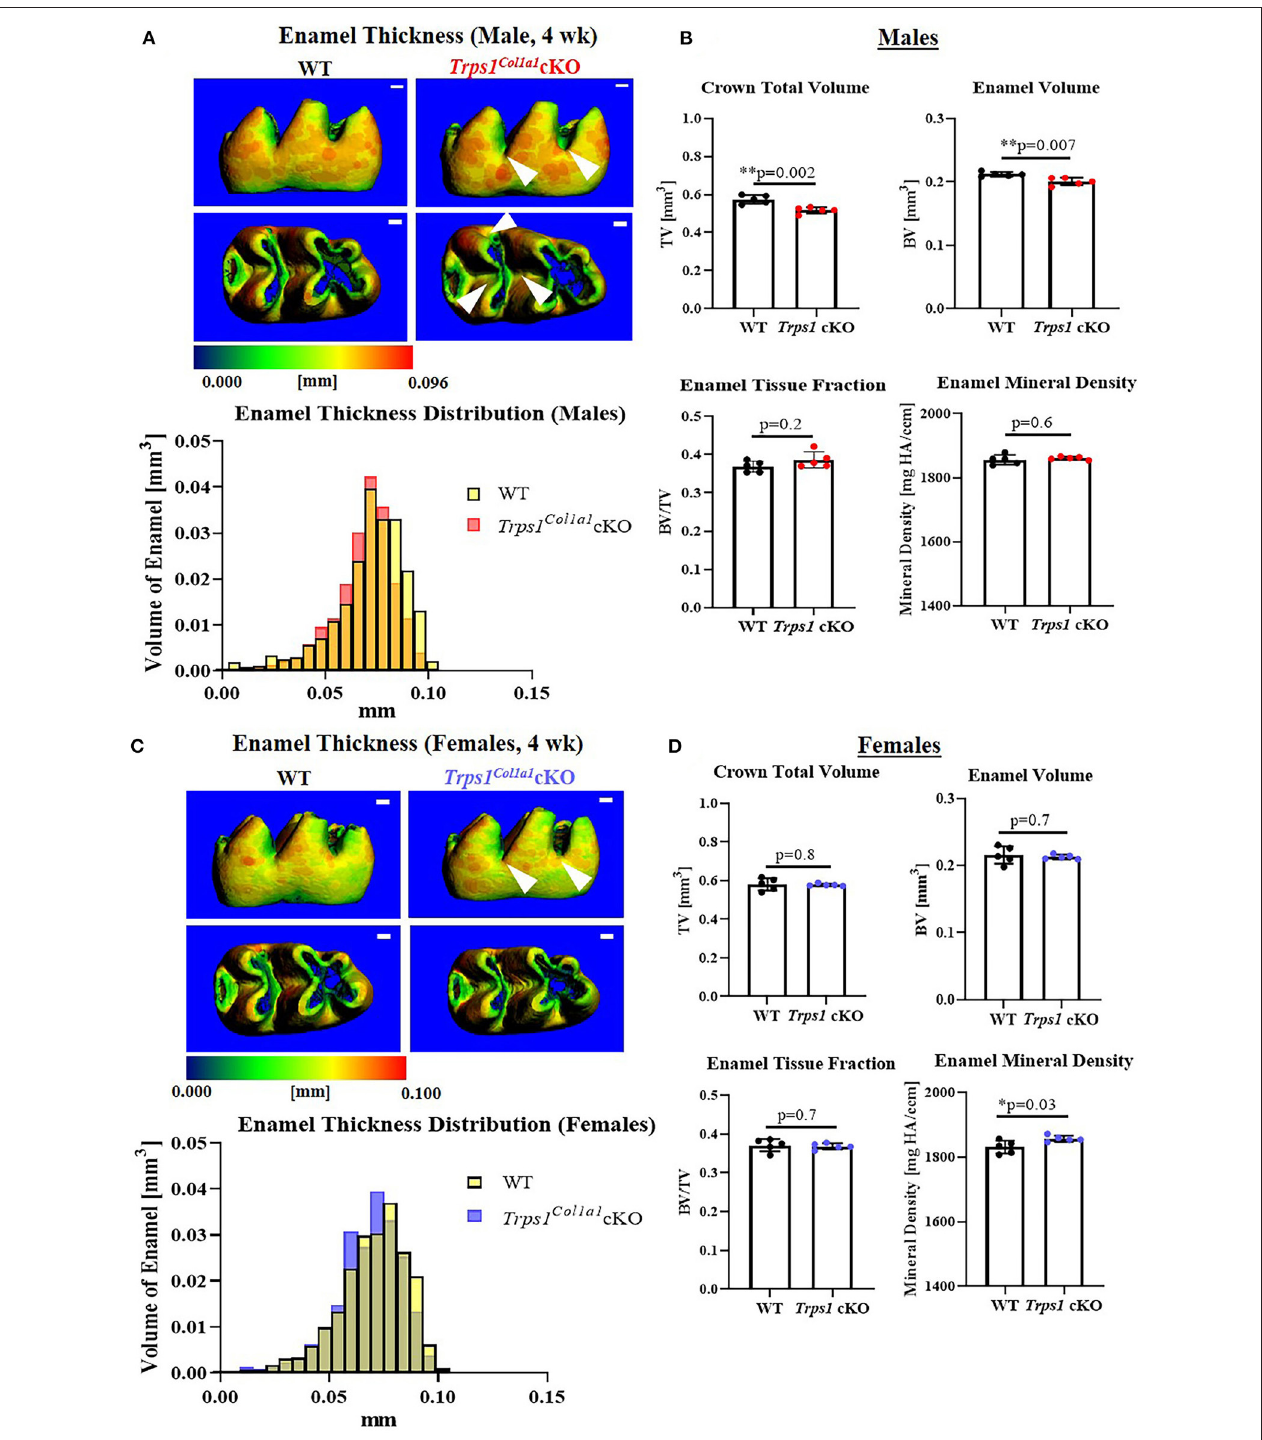
FIGURE 3 | Quantitative µ CT analyses of the enamel of mandibular first molars of 4 wk old WT and Trps1 Col1a1 cKO mice. (A,C) Representative 3D µ CT images of the enamel; scale bar = 100 µ m. The enamel was pseudo-colored based on the distribution of tissue thickness. The corresponding tissue thickness color scale is shown below the images. White arrowheads point at the reduced enamel thickness specifically in pits of Trps1 Col1a1 cKO male molars. There was no noticeable difference between WT and Trps1 Col1a1 cKO females. The graph below the 3D images shows the comparison of the quantity (volume) of the enamel with specific thickness in WT and Trps1 Col1a1 cKO. (B,D) Quantification of enamel volume, enamel tissue fraction in the total crown volume, and mineral density. Mean values ± SD and individual data points (dots, N = 5/genotype/sex) are shown; * p < 0.05 and ** p < 0.01.